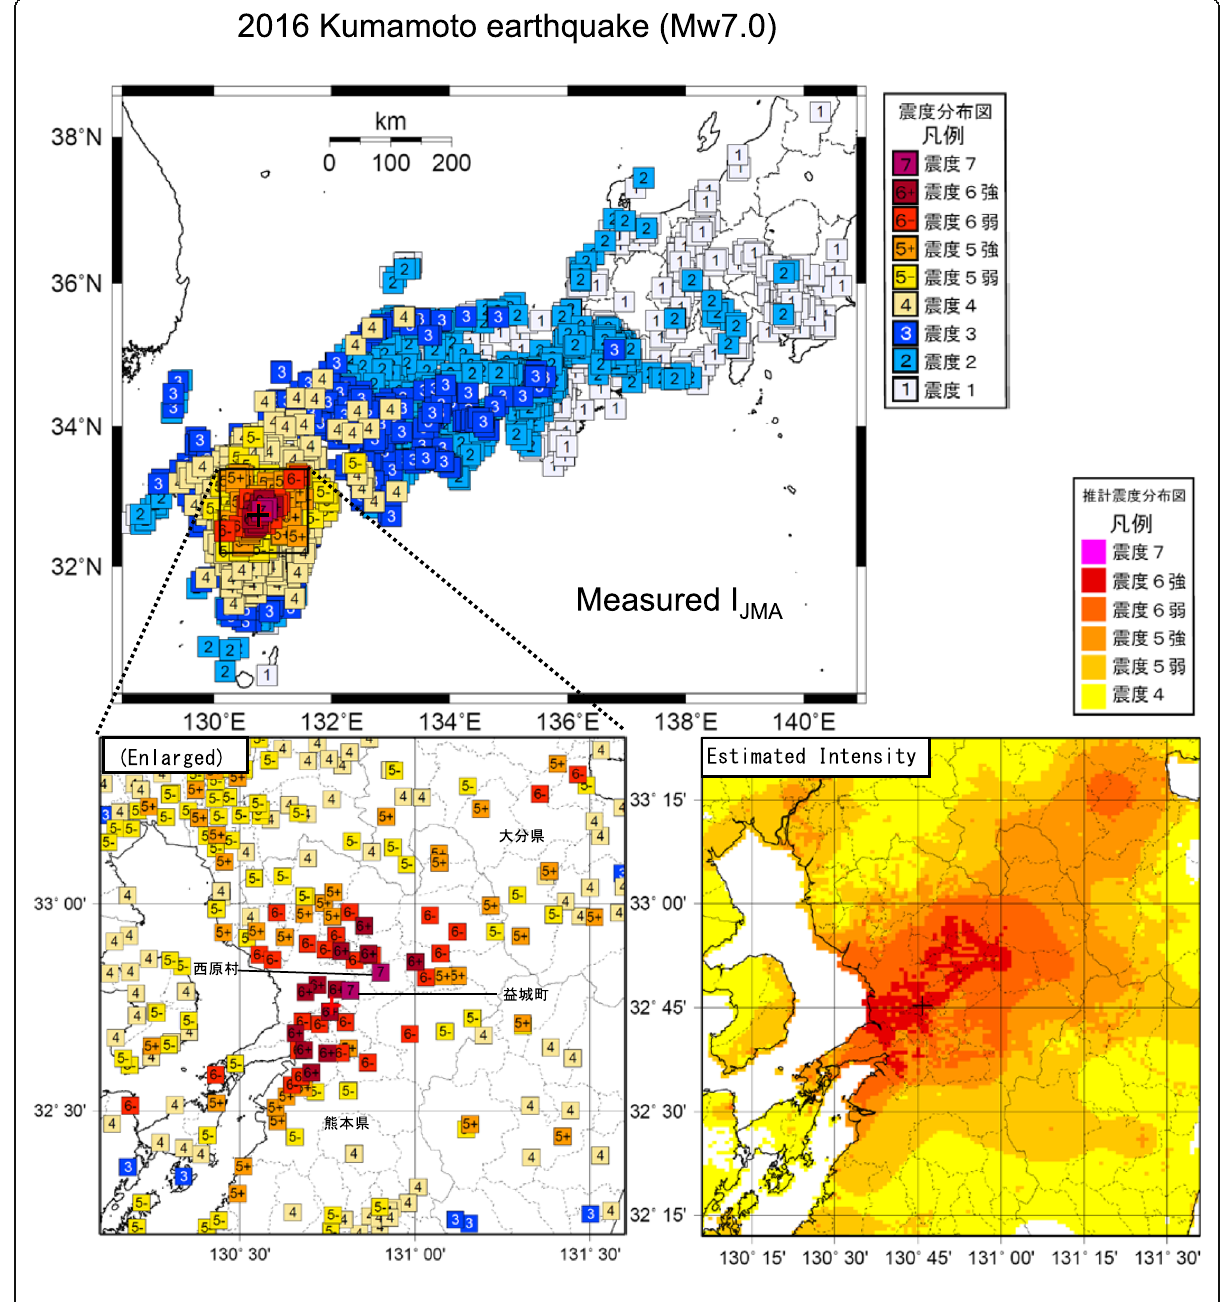
Fig. 9 Intensity ( I JMA ) distribution measured for the April 16, 2016 Kumamoto earthquake (Mw7.0). The instrument stations that measured intensities 6 − and larger are located in the area surrounding the epicenter (+) (top). This area around the epicenter is enlarged (lower left), and the estimated intensity distribution is shown by contours (lower